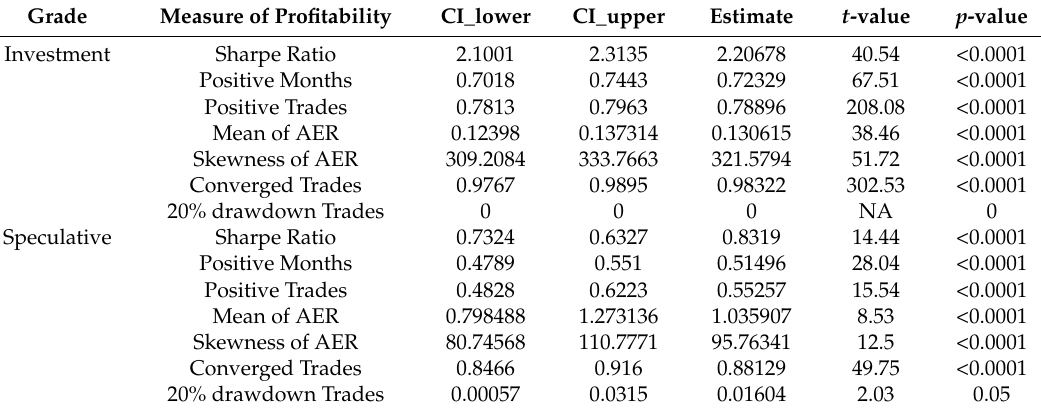
Table 6. Risk and Return Characteristics of